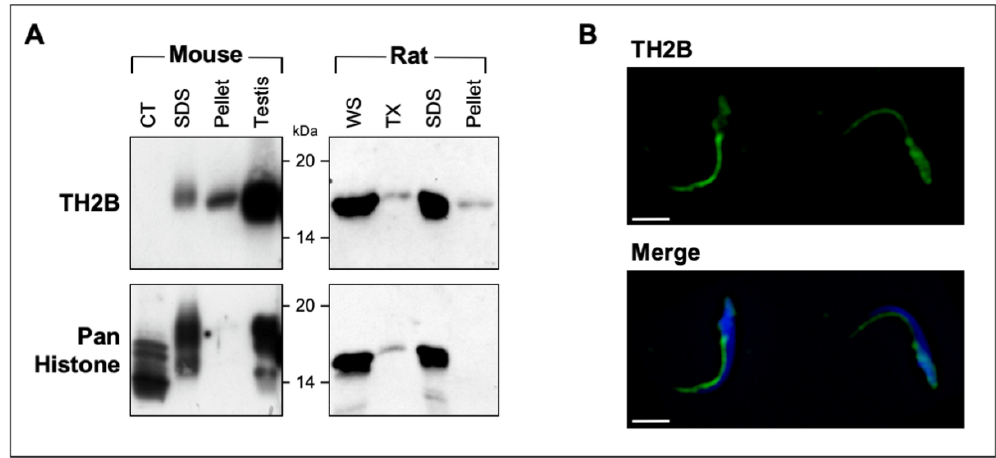
Figure 6. TH2B extractability and localization in murid spermatozoa: ( A ) Comparison of immunoreactivity between anti-TH2B and anti-pan histone antibodies on immunoblots of calf thymus histones (CT), 2% SDS extraction of spermatozoa (SDS), the sperm pellet after extraction (pellet), whole sperm (WS), 2% TX-100 (TX) extraction of spermatozoa, and testis homogenates (testis). According to the immunolabeling, anti-TH2B does not recognize somatic histones and is found in both SDS extracts and the resulting sperm pellet, indicating that it resides in the perinuclear theca and sperm nucleus, respectively. KCl extraction (not shown) showed similar results to SDS extraction. ( B ) Immunofluorescence confirmed TH2B’s presence in both the PAS and perforatorial regions of the PT. Bar = 5 μ M.